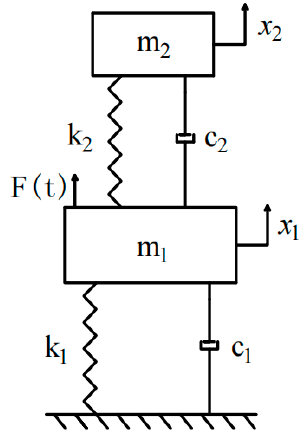
Figure 12. Schematic diagram of TMD.